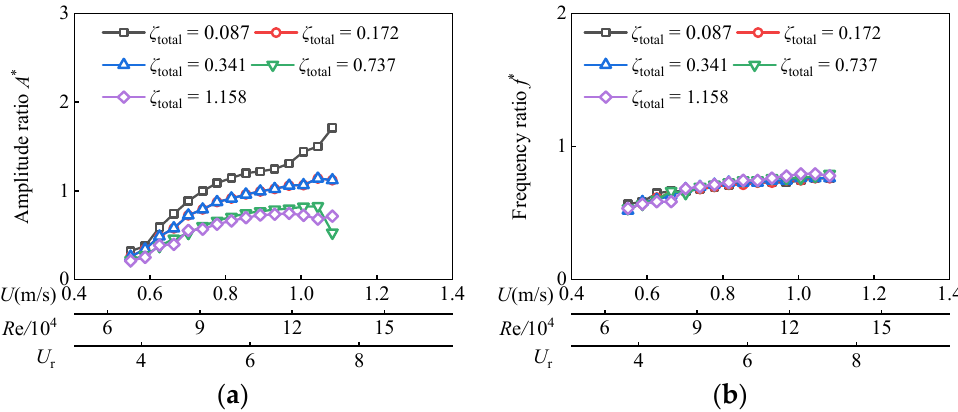
Figure 9. FIM of Cir-T-Att with D = 0.14 m, Re = 6.75 × 10 4 ~1.61 × 10 5 . ( a ) Amplitude ratio. ( b ) Frequency ratio.